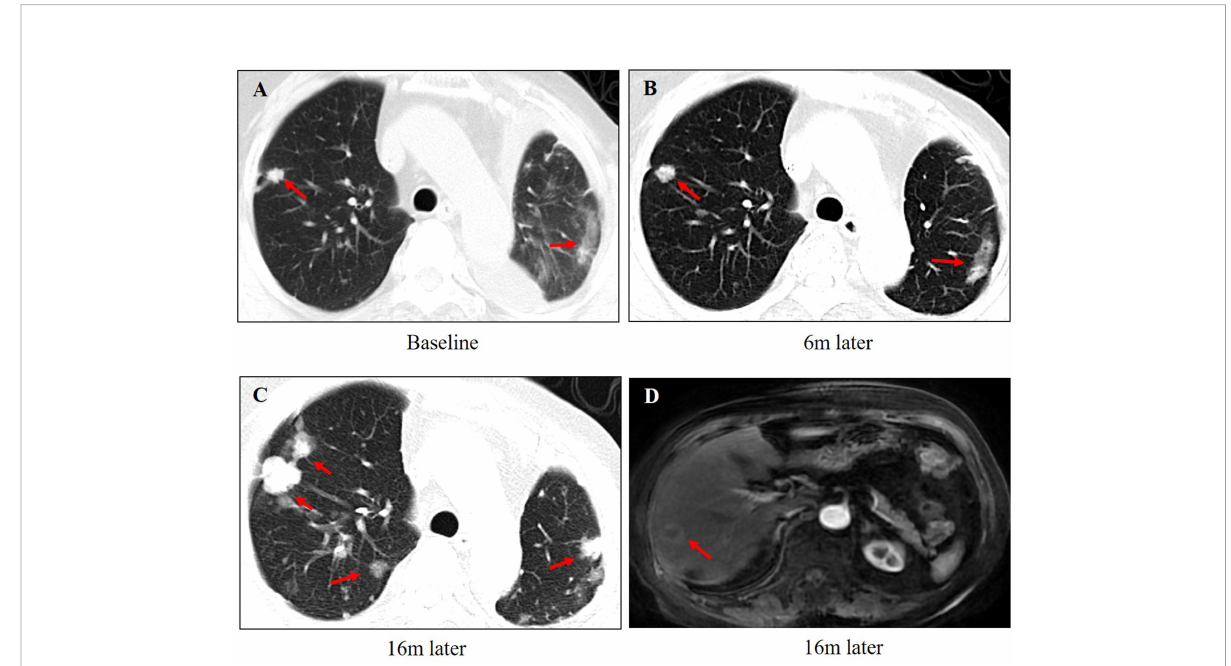
FIGURE 3 The changes in images during the treatment of abemaciclib and exemestane. (A) The baseline of lung metastasis at the beginning of abemaciclib and exemestane. (B) The lung lesions were stable after 6 months treatment. (C) The lung lesions progressed after 16 months of treatment. (D) Liver metastasis was found after 16 months of